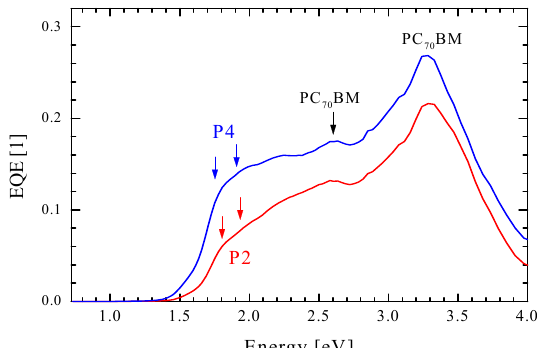
Figure 7. Quantum external efficiency (EQE) spectra of solar cells with P2 :PC 71 BM (red) and P4 :PC 71 BM (blue) heterojunctions. Energies of absorption peaks of P2 , P4 , and PC 71 BM are marked by arrows.